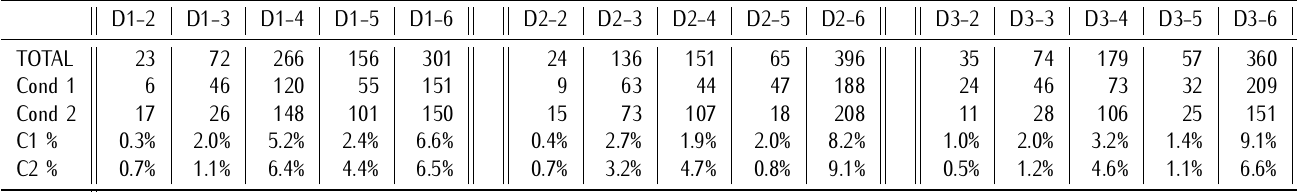
Table 1. Content-categorized talking by condition, with proportion of category given total available